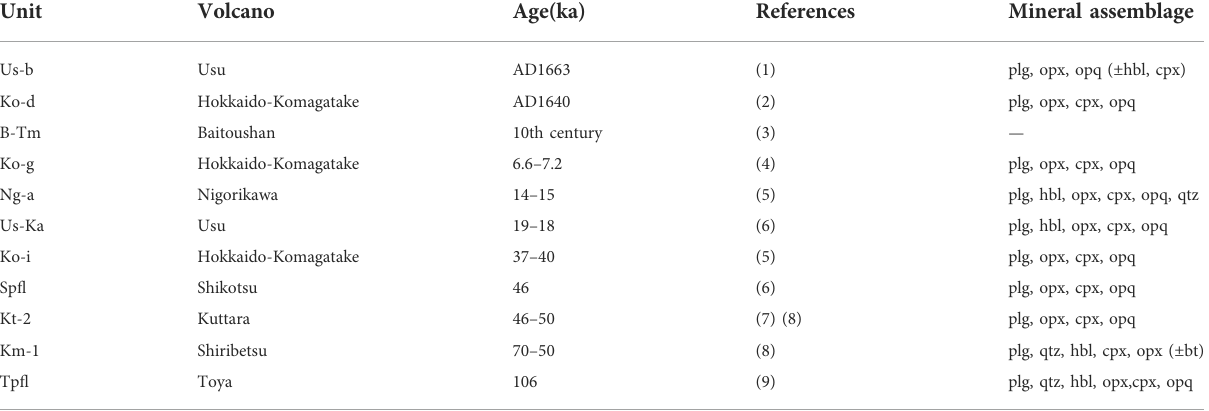
TABLE 1 List of marker tephra layers around Usu volcano.